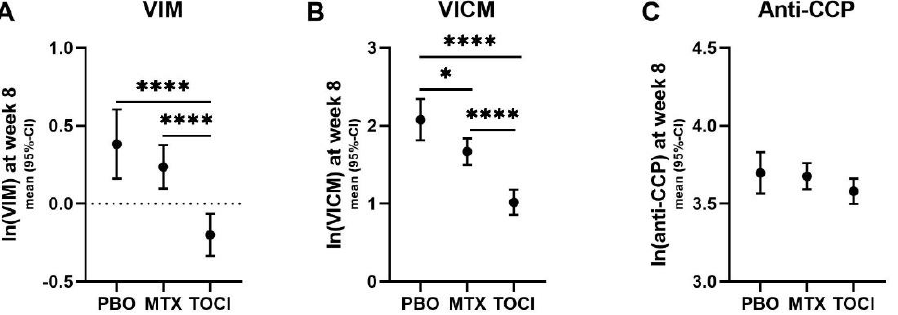
Figure 2. Serum levels of the biomarkers VIM, VICM and anti-CCP at week 8 post-treatment with placebo (PBO), methotrexate (MTX) or tocilizumab (TOCI). ANCOVA was used to compare between groups. Data are shown as estimated marginal means (95% CI) derived from ln-transformed data adjusted for age, sex, race, BMI, disease duration and baseline biomarker levels for the individual marker: *, p < 0.05 and ****, p < 0.0001. Table 3. Baseline prediction of response using the biomarkers including all patients. OR [95% CI] for being a responder from logistic regression comparing patients with the lowest levels of biomarker (first tertile) with the second and third tertiles at either baseline or at week 8. ORs were adjusted for baseline biomarker level (week 8 only), age, sex, BMI and disease duration. Ns, non-significant ( p >